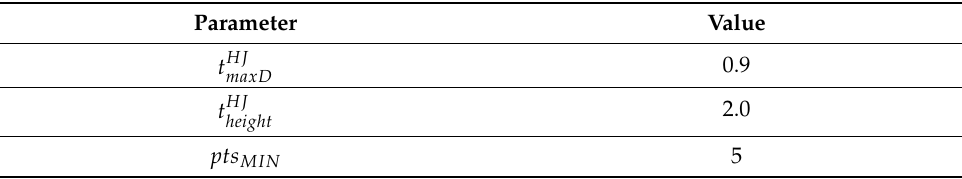
Table 1. Parameters used for the detection of height jumps.